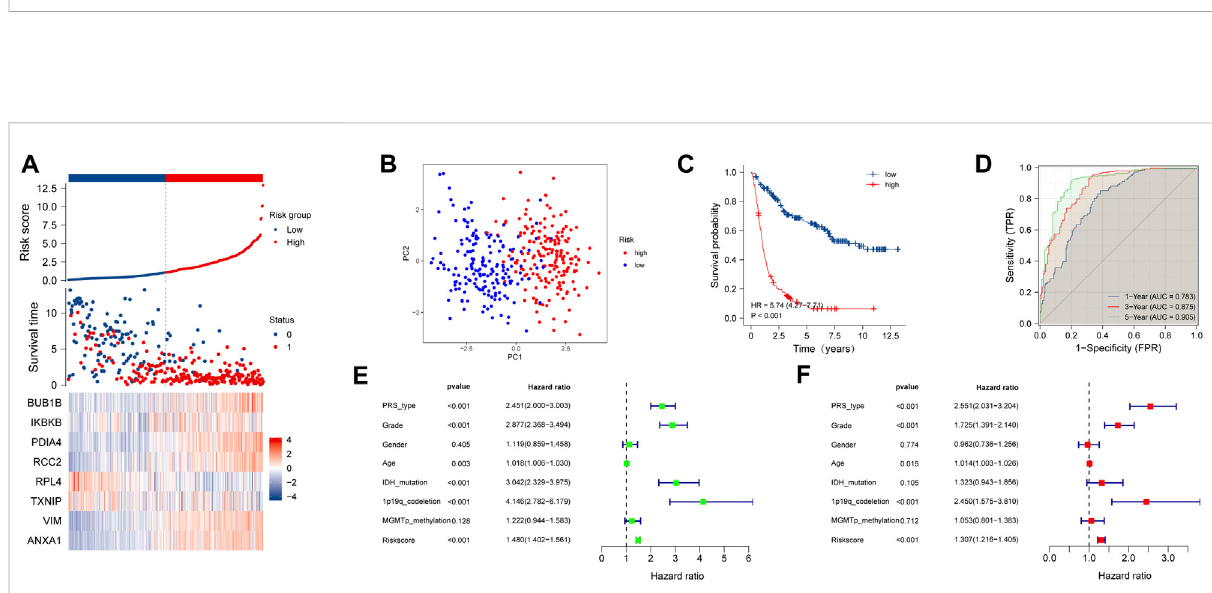
FIGURE 2 Assessment of the risk score model based on NRDEG prognostic signature in the training cohort (A) Risk score, survival distribution of patients with increased risk scores, and expression heatmap of NRDEGs based on risk level. (B) PCA of NRDEGs. (C) Kaplan – Meier survival of the training cohort. (D) AUC of the training cohort (1-, 3-, and 5-year). (E) Univariate COX regression analysis of the training cohort. (F) Multivariate COX regression analysis of the training